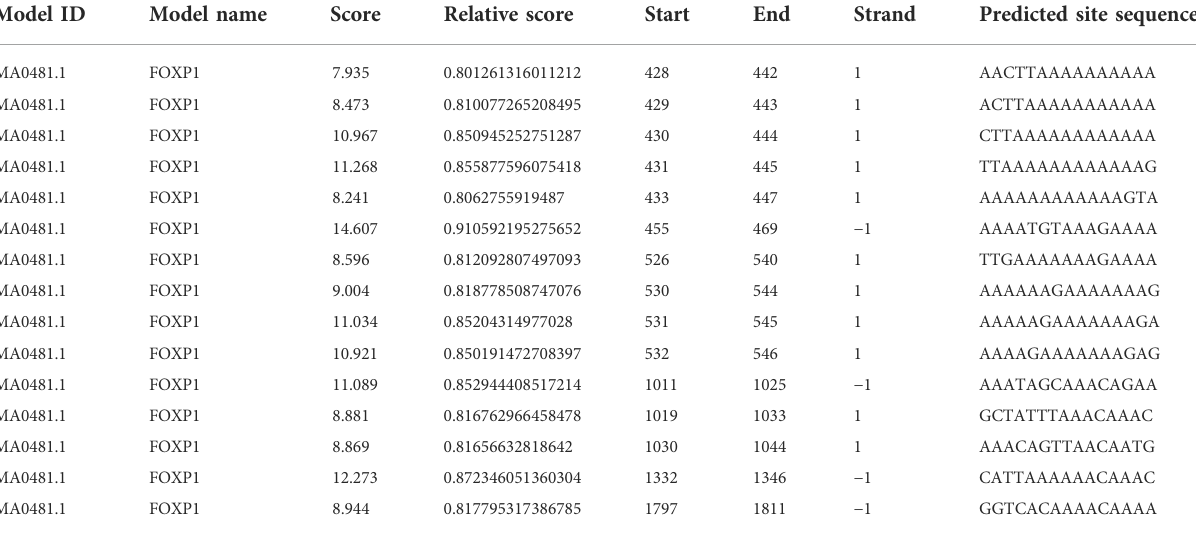
TABLE 1 Putative FOXP1-binding sites in the HIF1A-AS2 promoter region by JASPAR. Model